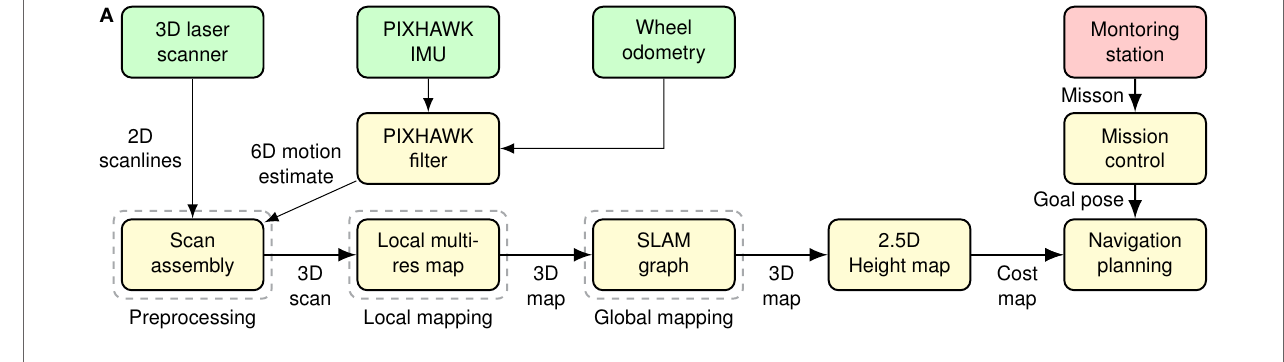
robot motion – efficiently implemented by using circular